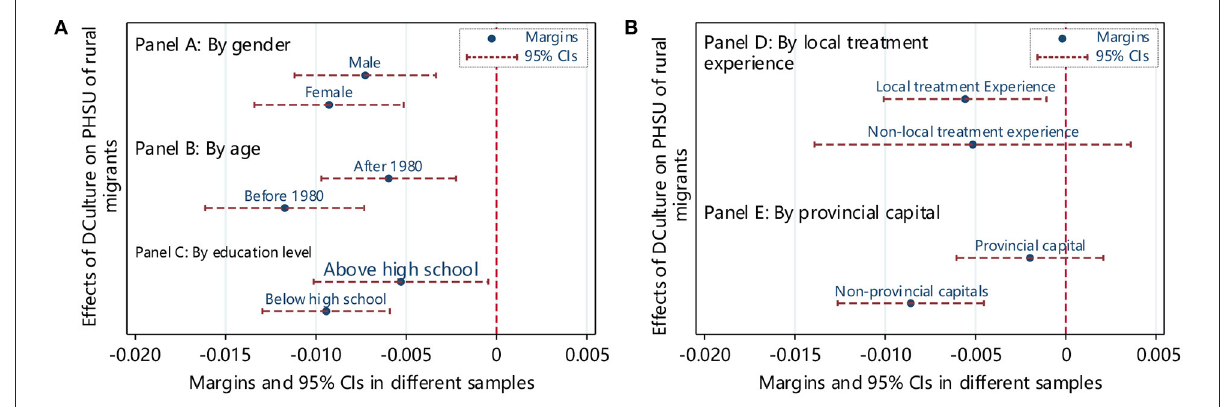
FIGURE4 (A,B) The heterogeneous effect of DCulture on PHSU of rural migrants. The control variables introduced in the model fit were consistent with those in Table